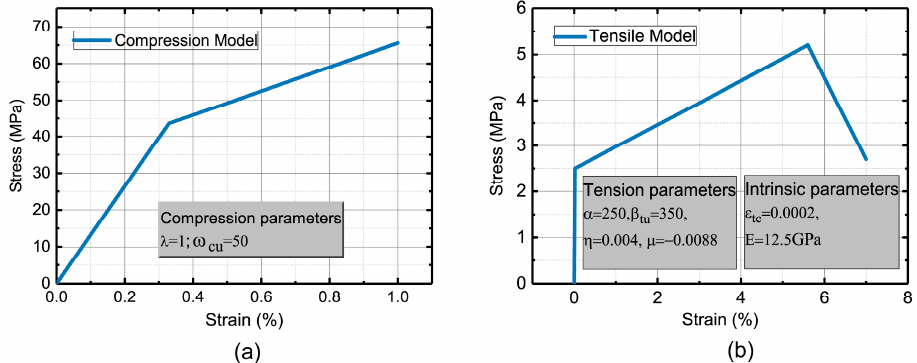
Figure 9. Thetypicalcurveobtainedfromtheuniaxialexperiment, ( a )compressionmodel; ( b Figure 9. The typical curve obtained from the uniaxial experiment, ( a ) compression model; ( b ) tension model.